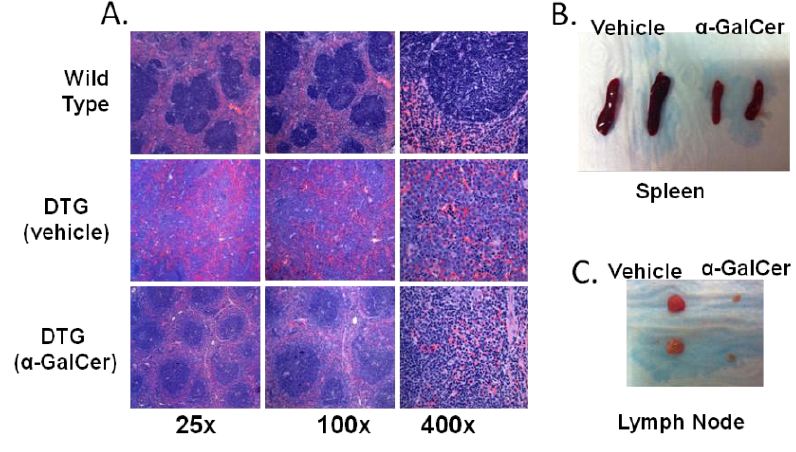
Figure 4. Activation of NKT cells reduces tumor burden in vivo . Eight-week old IL-14/c-myc double transgenic mice were treated with vehicle alone (DMSO) or α-GalCer (2 μg/mouse) in PBS i.v. and after six weeks, lymph nodes and spleens were harvested and examined for disease. ( A ) H&E staining of spleen sections shows improved splenic architecture and lower frequency of blastoid variant MCL cells as compared to vehicle treated controls; ( B ) spleens and ( C ) lymph nodes of α-GalCer treated mice show reduced splenomegaly and lymphadenopathy, respectively, as compared to vehicle-treated, littermate controls. These data are representative of three independent experiments of two to five mice per group; a total of 11 mice were treated with vehicle, and 10 were treated with